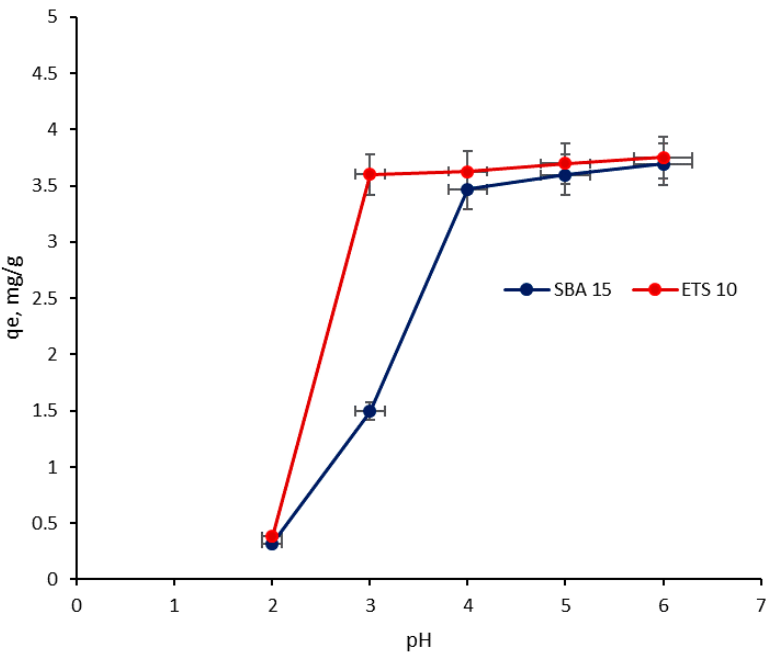
Figure 1. pH influence on the removal efficiency of SBA-15 and ETS-10 adsorbents toward Cu(II). (Ci 10 mg/L, time 60 min, temperature 23 °C, adsorbent dose 20 mg).